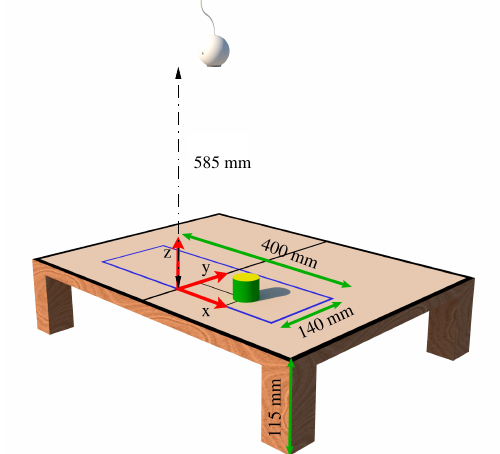
Figure 5. Dimensions of the area where objects are